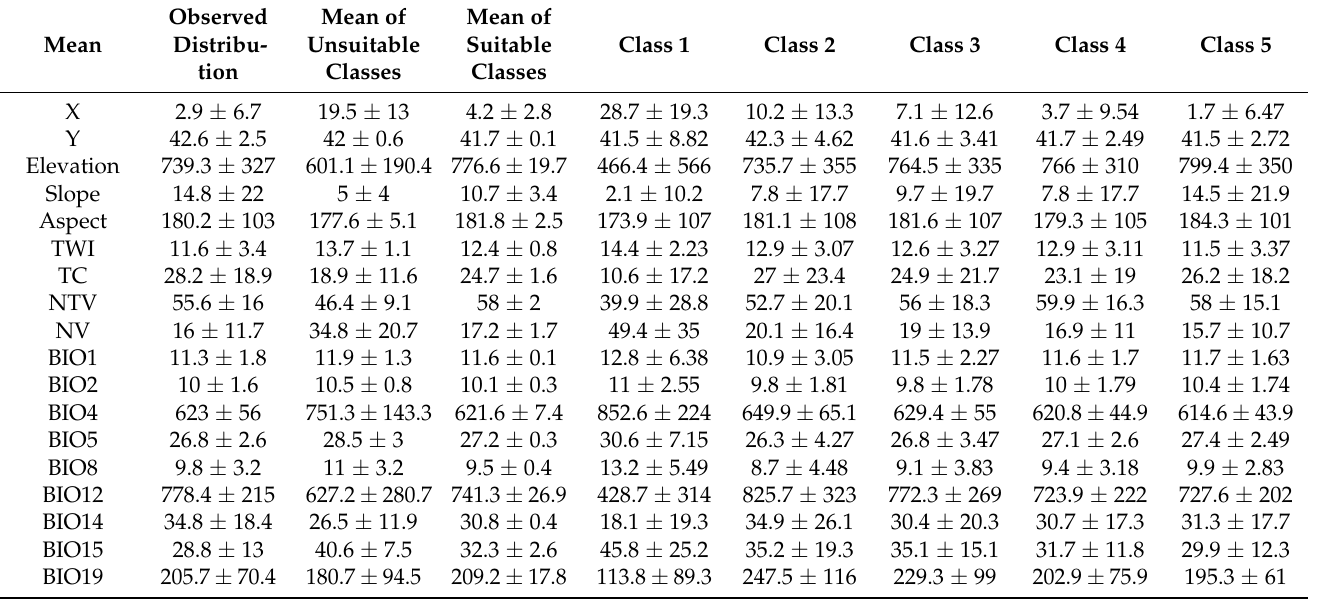
Table 3. Matrix of means environmental parameters based on the observed data, the predicted actual distribution, and the suitability classes.